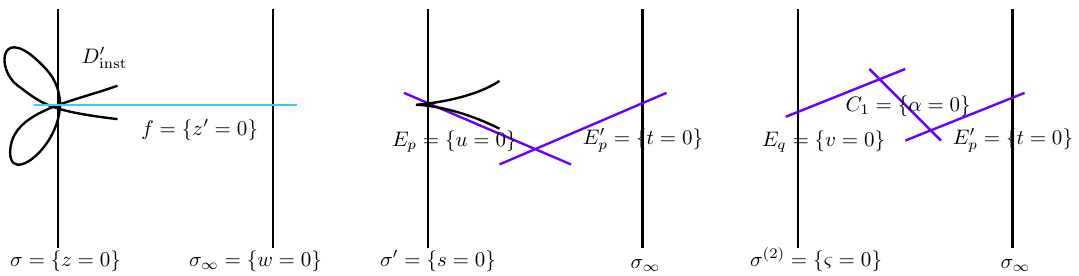
Figure 16. Resolutions of the k = 2 case. We blow up the collision point between II (cid:3) and IV singularities to obtain A 2 con(cid:12)guration. Compare with (cid:12)gure